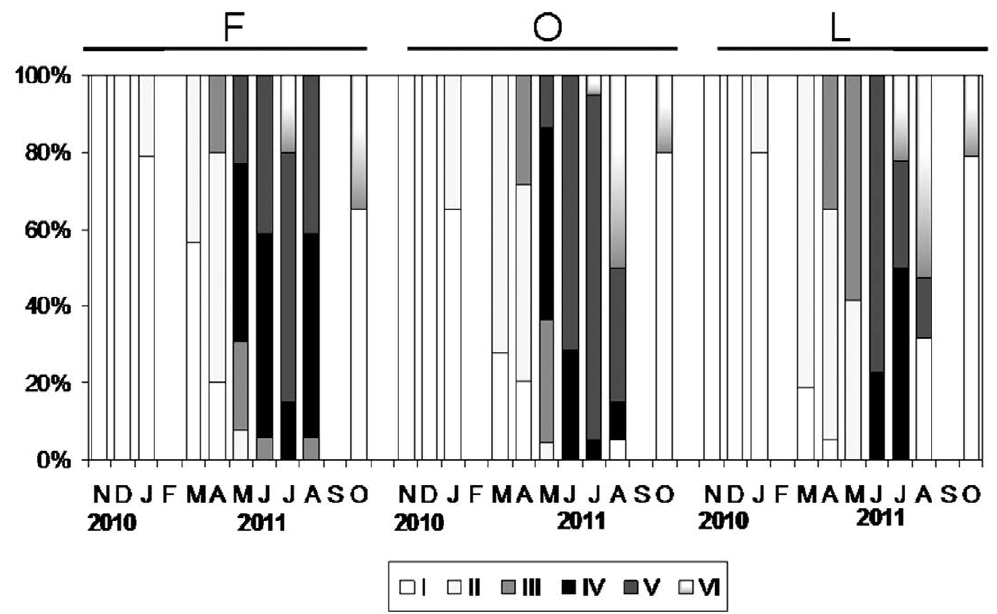
Fig. 2. – Maturation stages (phase I, sexual rest; phase II, gametogenesis beginning; phase III, advanced gametogenesis; phase IV, ripe; phase V, partially spawned; and phase VI, spent) of the clam Ruditapes decussatus (n=20) transplanted to sites F, O and L; data over an annual cycle.